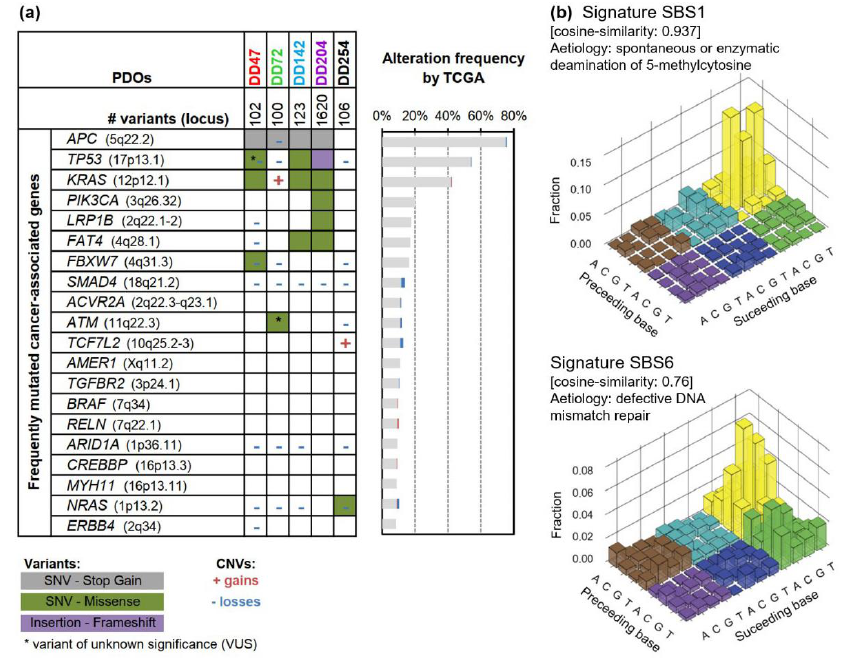
Figure 1. Genetic characterization of CRC patient-derived organoids (PDOs). ( a ) Oncoplot of gene mutations and copy-number variations (CNVs) of PDOs. The 20 most frequently mutated cancer- associated genes (according to the OncoKB database [40]) are listed with their mutation frequency according to The Cancer Genome Atlas (TCGA) CRC dataset (mutation frequency n = 224; CNV frequency n = 257) [41]. ( b ) Mutational signatures were detected for CRC PDOs, which could be assigned to SBS1 (deamination of 5-methylcytosine, cosine similarity 0.937) and SBS6 (defective DNA mismatch repair, cosine similarity 0.76). SNV: single nucleotide variant; SBS: single-base substitution. Sequencing revealed the typical CRC mutation pattern as described by The Cancer Genome Atlas (TCGA) study (Figure 1a, Figure S2, Table S2) [41]. The analyzed PDOs contained 89 − 1620 variants including inactivating mutations of the tumor suppressors APC and TP53 as well as activating mutations of the oncogenes KRAS , NRAS , or PIK3CA . Interestingly, DD72 revealed an ATM (ataxia telangiectasia mutated) p.Leu2427Arg mutation with uncertain significance, and DD142 carried a heterozygous NBN (nibrin) p.Ser369* mutation. Both encoded proteins are important for sensing and repairing of DNA damage. Typical CRC copy-number variations with recurrent gains on 7p, 12q, and 20p/q occurred (encoding, for example, for BCL2L1 and SRC ) and losses within 1p, 4q, 8p, 14q, 15q, 17p, and 18p/q (resulting in deletions of, for example, ARID1A , TP53 , and SMAD4) (Figure S3, Table S3). Analyzing the mutational signatures of the five PDOs, two signatures could be assigned, which showed the highest similarity to single-base substitution (SBS) 1 and SBS6 (cosine similarity: 0.937 and 0.76) (Figure 1b). Both are characteristic for CRC [35,36], whereas SBS1 is associated with spontaneous deamination of 5-methylcytosines, resulting in C>T transitions, and correlates with age, and SBS6 is linked to mismatch repair deficiency. 3.2. Heterogeneous Response of CRC PDOs upon Irradiation The response of CRC PDOs toward radiotherapy was analyzed. As proton therapy has not yet been examined using CRC organoids, the lines were irradiated with both beam